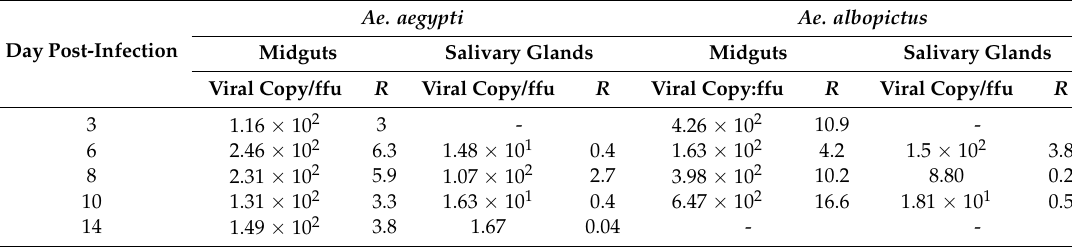
Table 3. Viral copy/ffu ratio in Ae. aegypti and Ae. albopictus midguts and salivary glands. Day Post-Infection